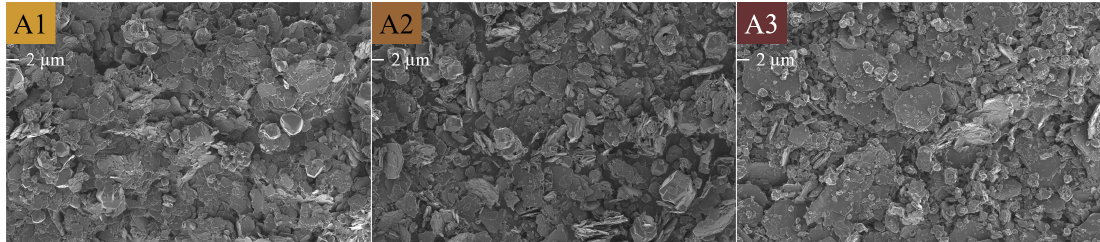
Figure 17. SEM micrographs of the chemical morphology/crystallinity of Al(OH) 3 series A1 = SA, A2 = ACE and A3 = M taken at 1keV and 2k magnification. The scale bar is indicated below the label.